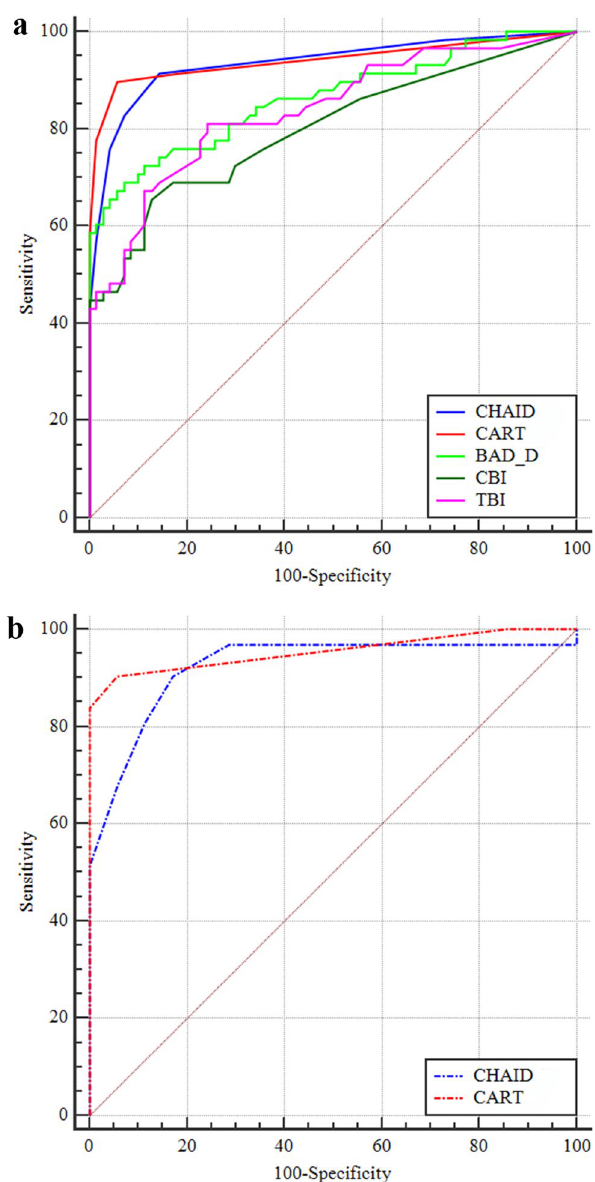
Figure 3. The ROC curves of the CHAID model, CART model, BAD-D, CBI, and TBI are presented in ( A ); the ROC curves of the two models in the validation database are presented in ( B ). ROC, receiver operating characteristic; BAD-D, Belin/Ambrósio deviation index; CBI, Corvis biomechanical index; TBI, tomographic and biomechanical